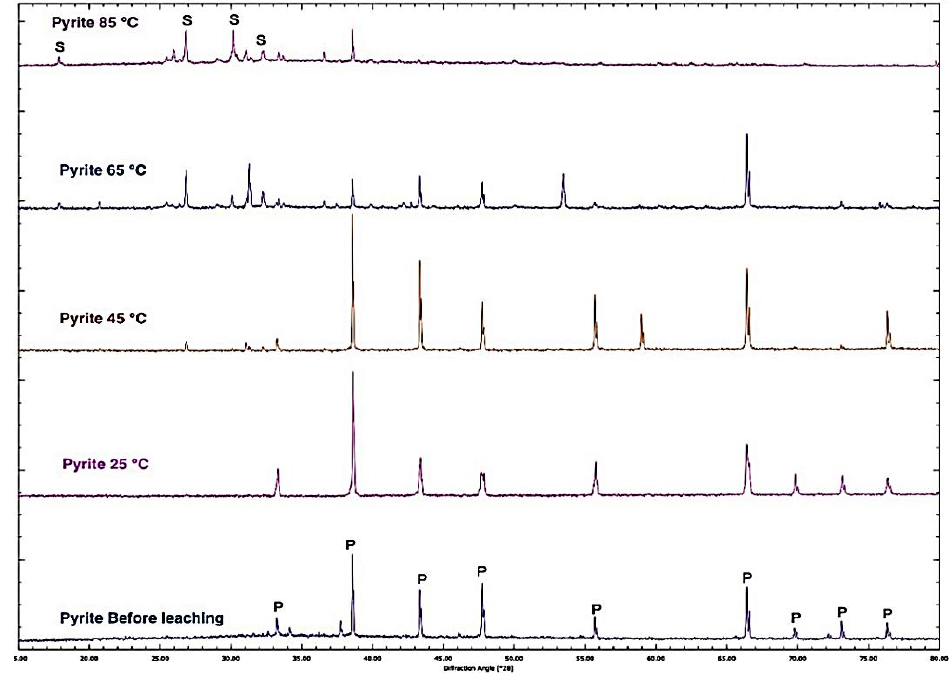
Figure 18. The XRD pattern of pyrite samples before leaching and the residue of leached pyrite in 3 M nitric acid at different temperatures of 25, 45, 65, and 85 °C.